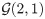
Simulated cue- and press-aligned changes in dopamine concentration, for comparison with Fig 4.Simulated average changes (±SEM) in dopamine concentration for the case where the critic receives both direct and indirect communication, asymmetric convolution of TD errors. (A) Cue-aligned, all trials. (B) Press-aligned, short-latency (<5 s) trials. (C) Press-aligned, long-latency (>5 s) trials. Insets show average peak changes (+SEM) in dopamine around the time of cue presentation and time of lever press. Number of simulated trials N = 1000, realizations of T drawn G(2,1). Model parameters as before: a = −1, b = 0, r = 1, k = 0.1, τ
post = 0.5 s, τ
I = 30 s.